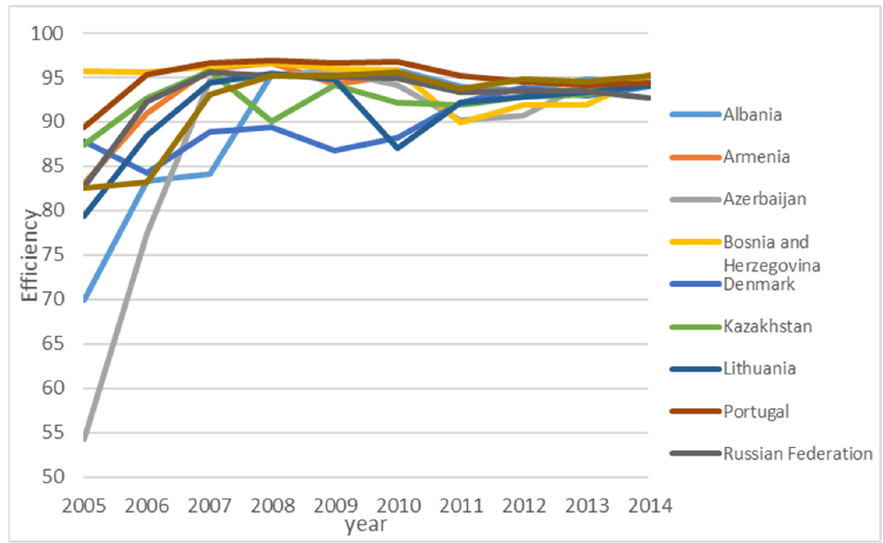
Figure 5. Countries with consistent efficiency improvement over time.